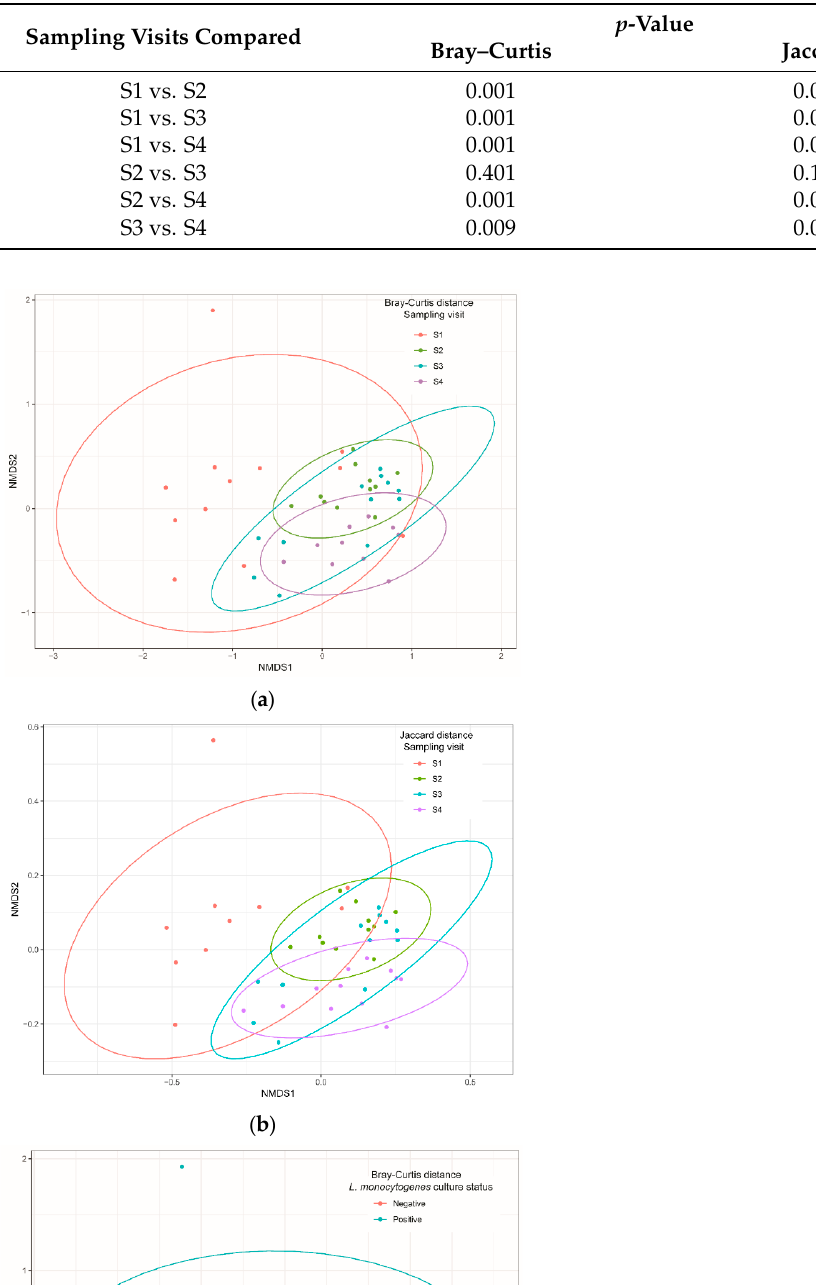
Table 2. Pairwise PERMANOVA analysis based on Bray–Curtis and analysis of variance using Jaccard distance matrices with 999 permutations.